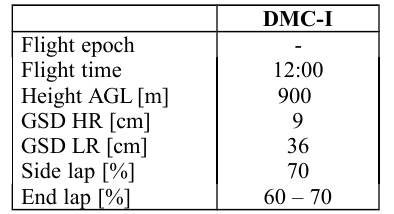
Table 5. Standard urban green flight parameters